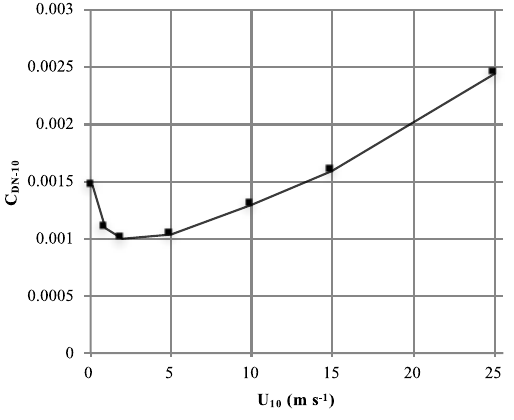
Figure B1. Scaling of the 10m neutral drag coefficient with wind speed, U 10 (Eqs.